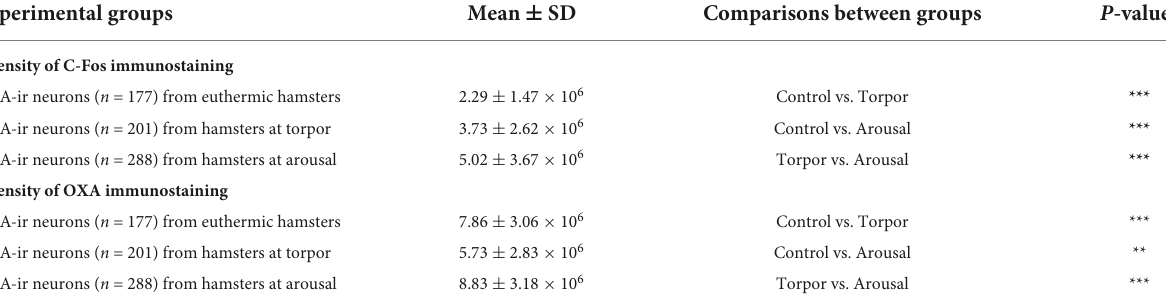
TABLE 3 Table showing mean ± SD values of C-Fos (top) and orexin A (bottom) intensity of immunostaining of orexinergic neurons from hamsters at euthermia, torpor, and arousal; p -values corresponding to the comparisons between total cells obtained from hamsters in the different hibernation phases (ANOVA with Bonferroni; SPSS software,